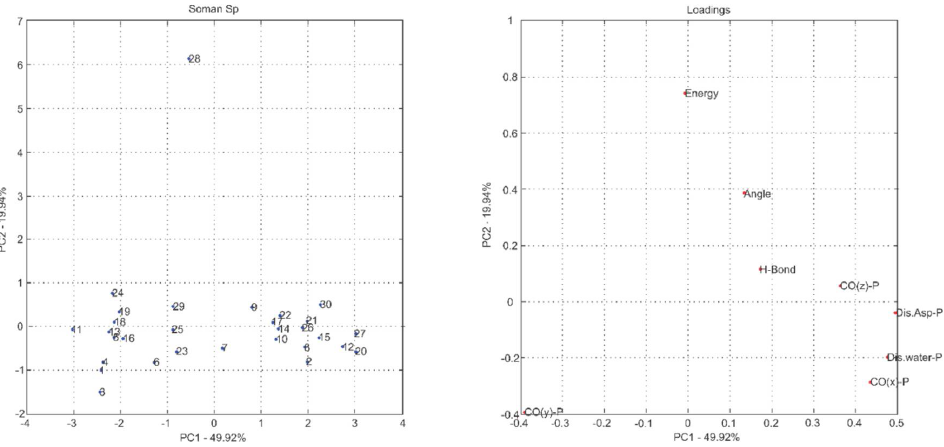
Figure 6. PC1 versus PC2 projection for Soman ( R P enantiomer) and loadings graph of the variables investigated ( left and right , respectively).